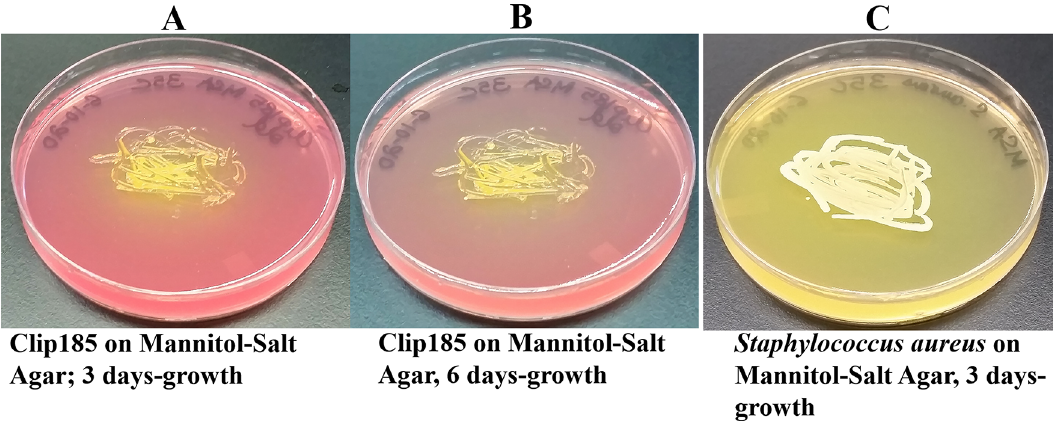
Figure 8. Clip185 growth on Mannitol Salt Agar (MSA) medium. (A) 3 days-growth of Clip185 on MSA plate. (B) 6 days-growth of Clip185 on MSA plate . (C) 3 days-growth of Staphylococcus aureus on MSA plate. Media plates were incubated at 30 °